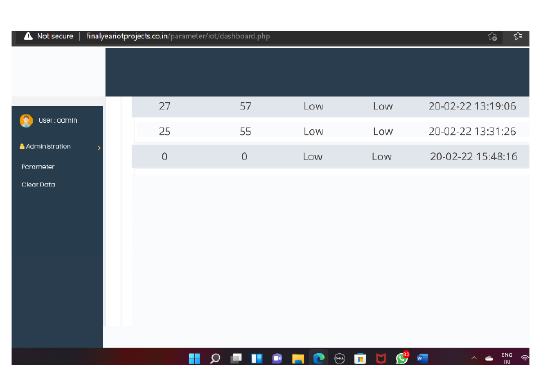
Fig.4(b) Real time data reading